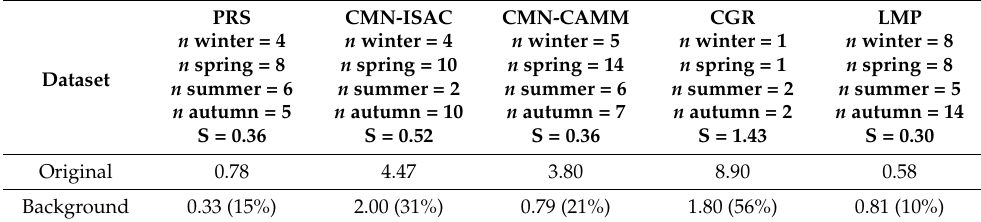
Table 3. Median amplitude of the diurnal variation (expressed in ppm) and percentage of data removed (in brackets) for each measurement site using seasonal values of n . The values of S and of the retrieved optimal n parameters are reported for each site.